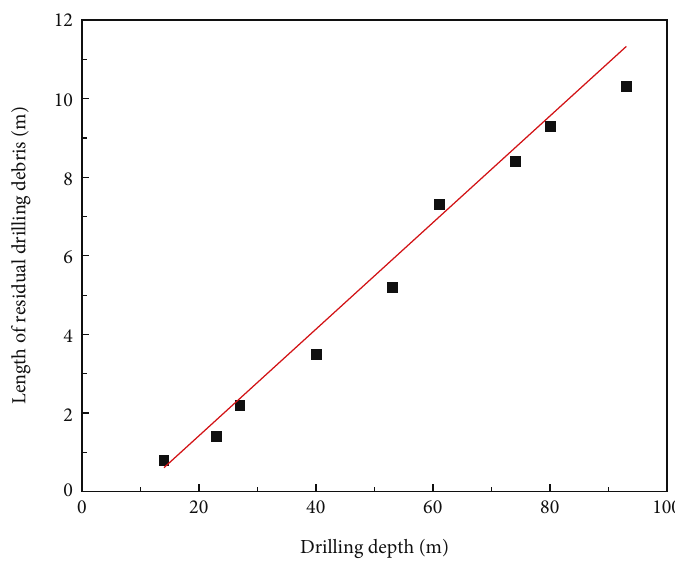
Figure 7: The linear relationship between the lengths of residual drilling debris and drill hole depths. Table 3: The parameters of Equation (1) between the residual lengths for drilling debris and depth. Linear fi tting parameters A